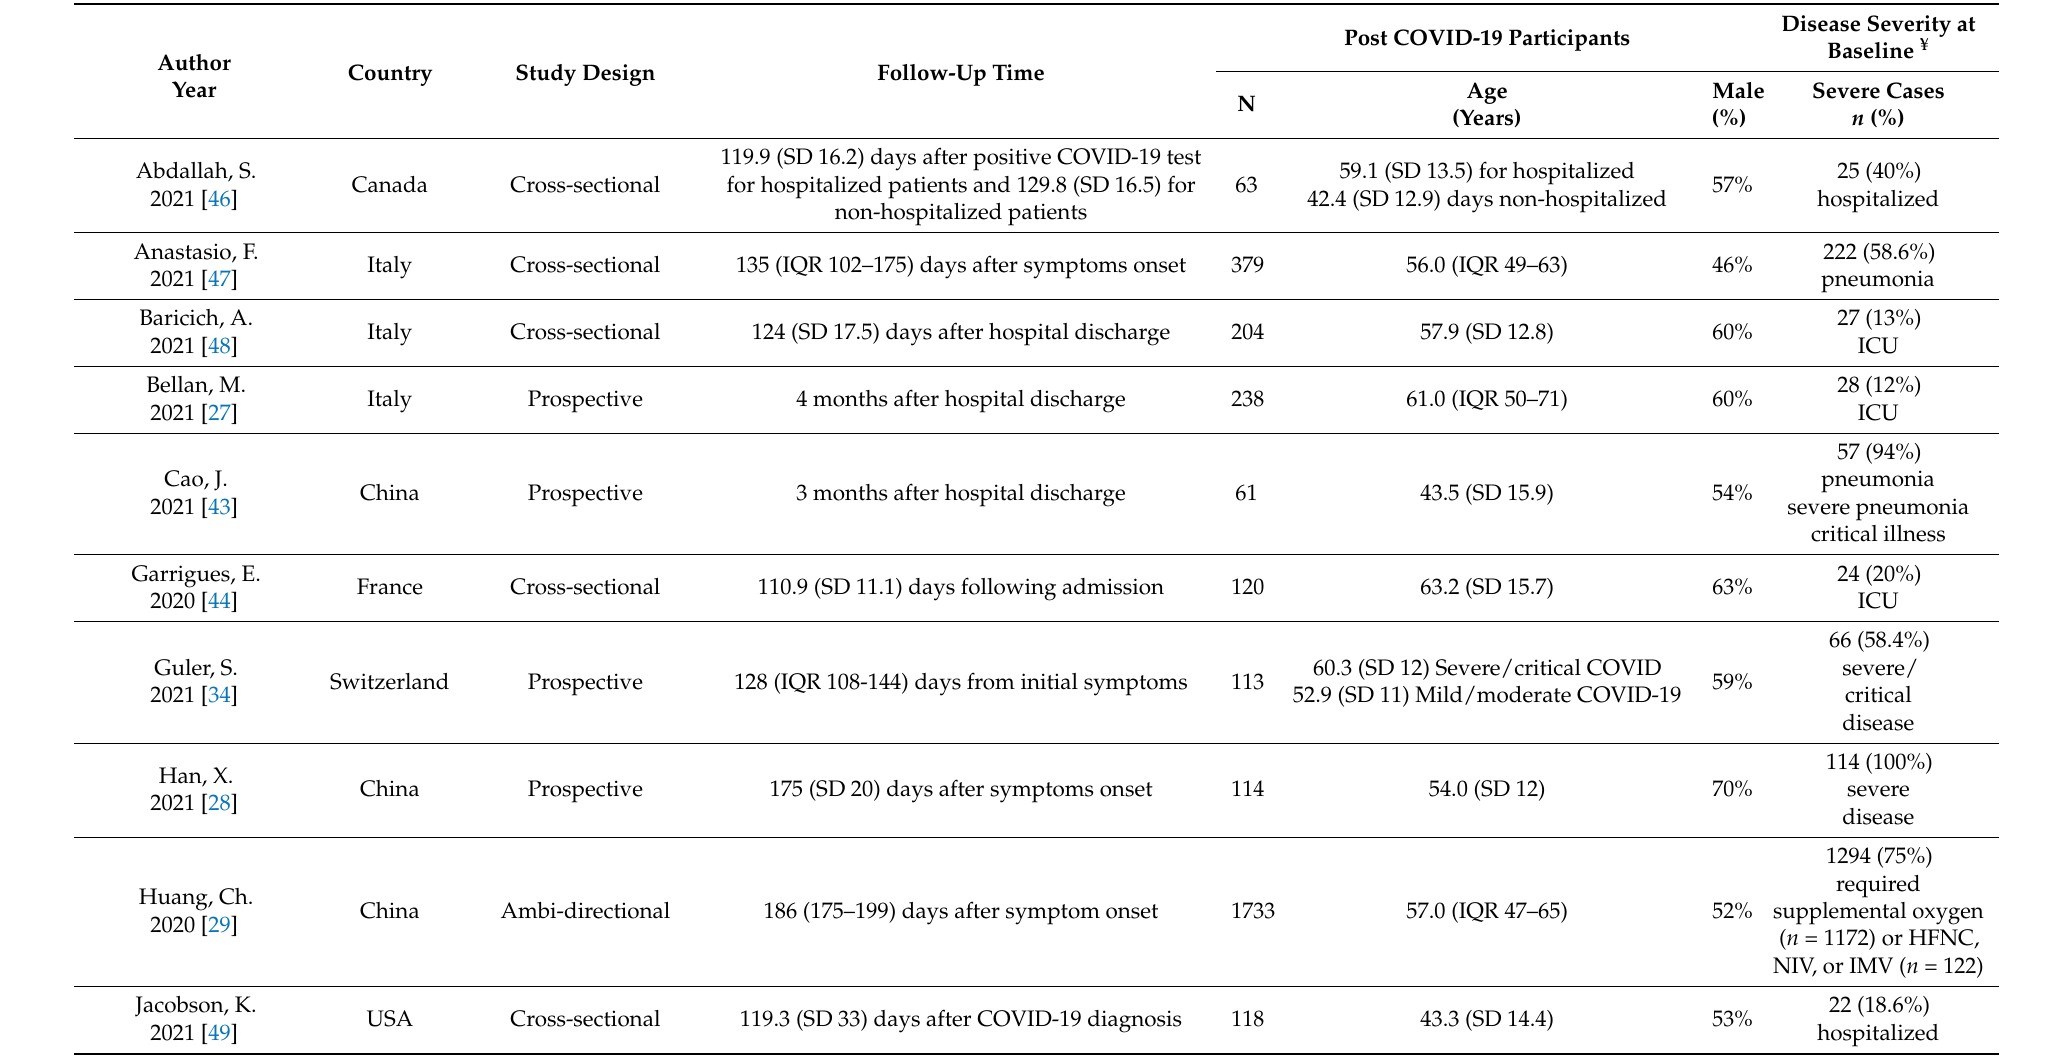
Table 1. Characteristics of the studies included ( n =